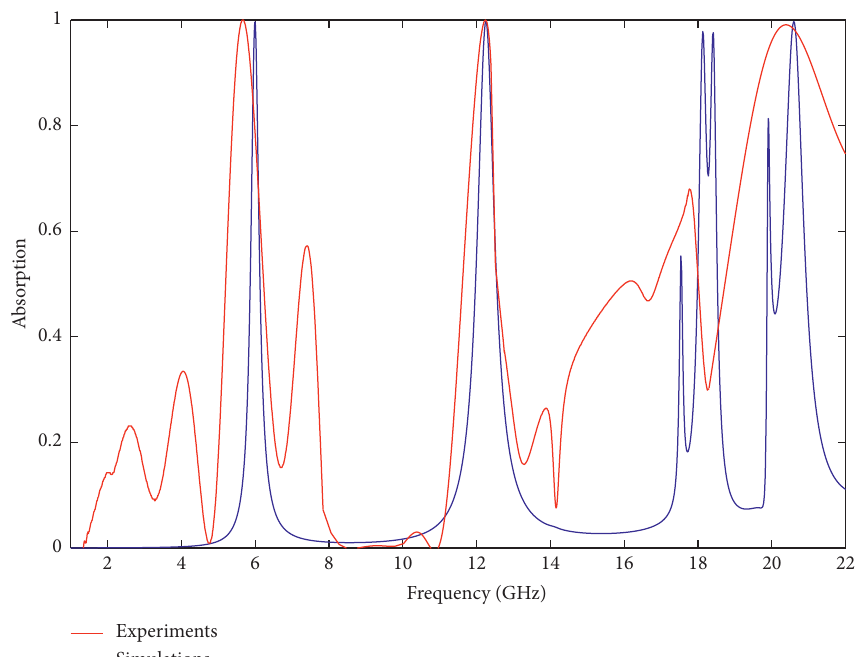
Figure 11: Comparison of experimental and simulation